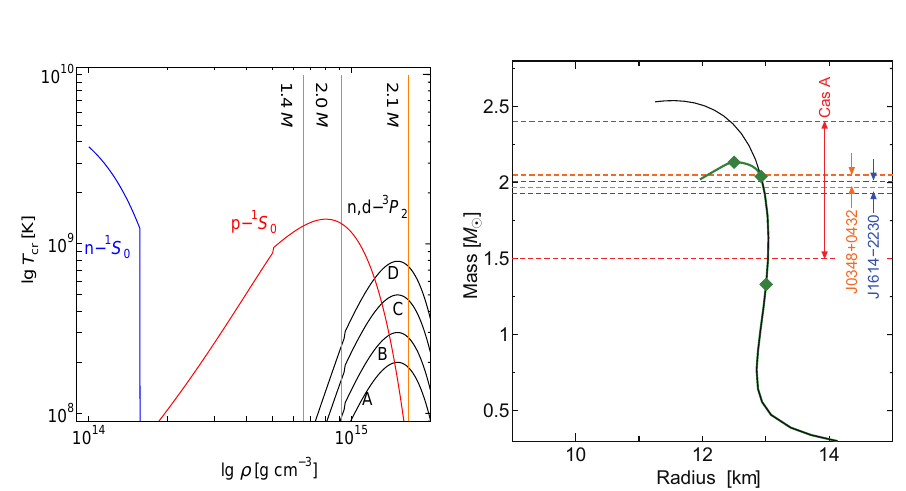
Figure 1. Superfluid temperatures of each state. Black lines denote the di ff erence of neutron 3 P 2 model.